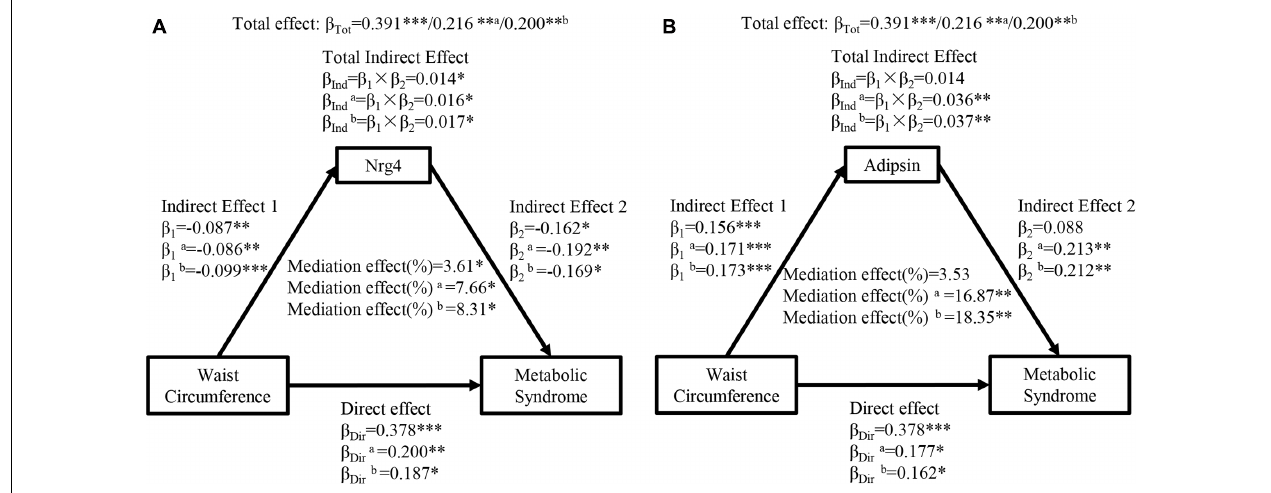
FIGURE 1 | Ngr 4 and adipsin mediate the effect of waist circumference on metabolic syndrome. (A) Mediation analysis of Nrg4. (B) Mediation analysis of adipsin. β , standardized regression coefficient; β